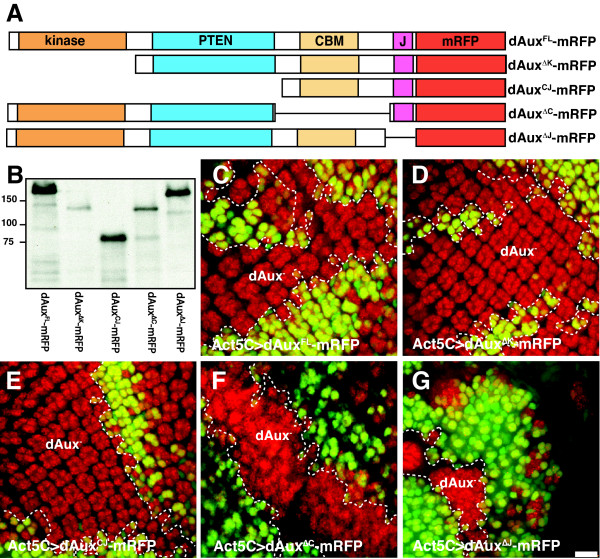
The CBM and J-domains are necessary for dAux function in Notch signaling. (A) A schematic diagram depicting various mRFP-tagged dAux constructs (see text for explanation). (B) A Western blot of extracts from flies expressing dAuxFL-mRFP (lane 1), dAuxΔK-mRFP (lane 2), dAuxCJ-mRFP (lane 3), dAuxΔC- mRFP (lane 4), and dAuxΔJ-mRFP (lane 5) under the control of Act5C-Gal4. The blot was stained with anti-DsRed antibody, which recognizes the mRFP tag. The sizes of protein standards (in kD) are indicated on the left. (C-G) Projected spinning disk confocal images of larval eye discs from (C) Act5C>FLP/UAS-dAuxFL-mRFP; FRT5-5Z3515, dAuxF956*/FRT5-5Z3515, ubi-GFPnls, (D) Act5C>FLP/UAS-dAuxΔK-mRFP; FRT5-5Z3515, dAuxF956*/FRT5-5Z3515, ubi-GFPnls, (E) Act5C>FLP/UAS-dAuxCJ-mRFP; FRT5-5Z3515, dAuxF956*/FRT5-5Z3515, ubi-GFPnls, (F) Act5C>FLP/UAS-dAuxΔC-mRFP; FRT5-5Z3515, dAuxF956*/FRT5-5Z3515, ubi-GFPnls, and (G) Act5C>FLP/UAS-dAuxΔJ-mRFP; FRT5-5Z3515, dAuxF956*/FRT5-5Z3515, ubi-GFPnls. These eye discs were stained with α-Elav antibody (red), and dAuxF956* mutant clones are indicated by the absence of nuclear GFP (green) and outlined by white dotted lines. The fluorescence from mRFP was not shown to present a clearer view of the organization of Elav-positive cells in dAux clones. Scale Bar, 10 μm.